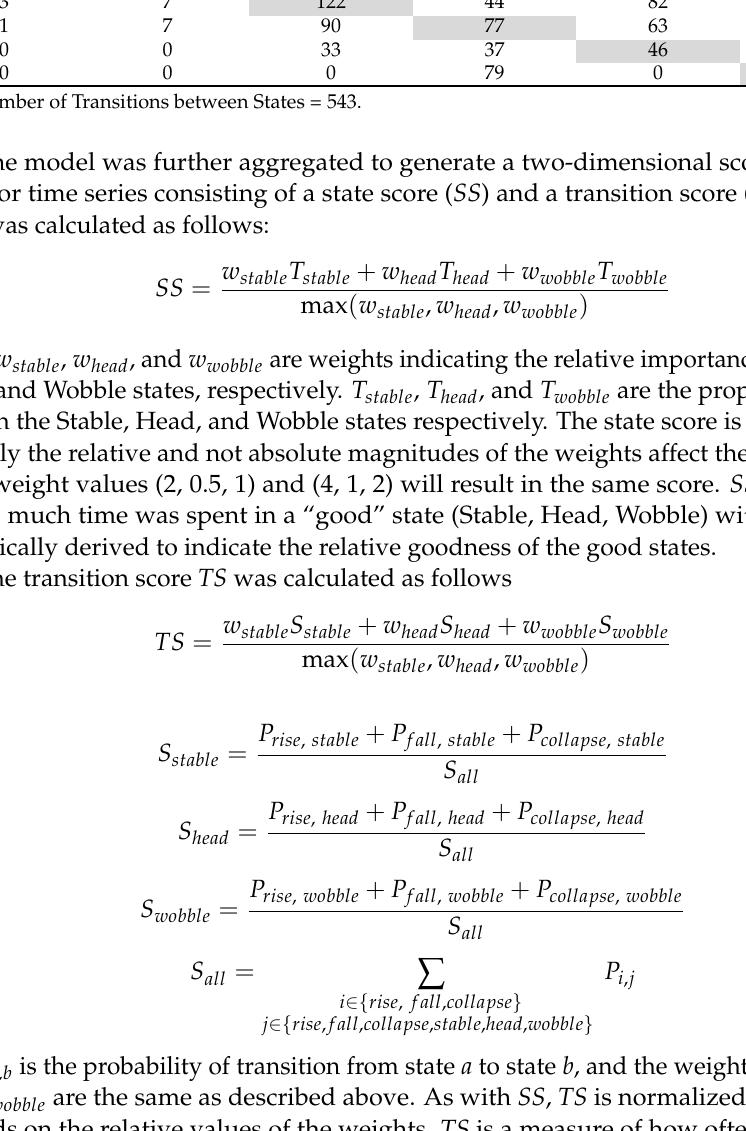
Table 3. Raw behavior transition counts for data represented in Figure 5. The diagonal (gray shaded) cells indicate same state transitions. Next State Stable Head Wobble Rise Fall Collapse Stable 0 1 2 0 1 0 Head 15 Current 0 State Fall 0 0 33 37 46 78 Collapse 0 0 0 79 0 148 Total Number of Transitions between States =